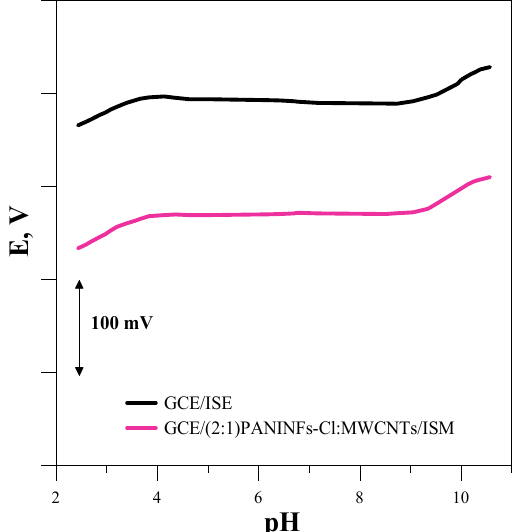
Figure 8. Dependence of electrode potential on pH.